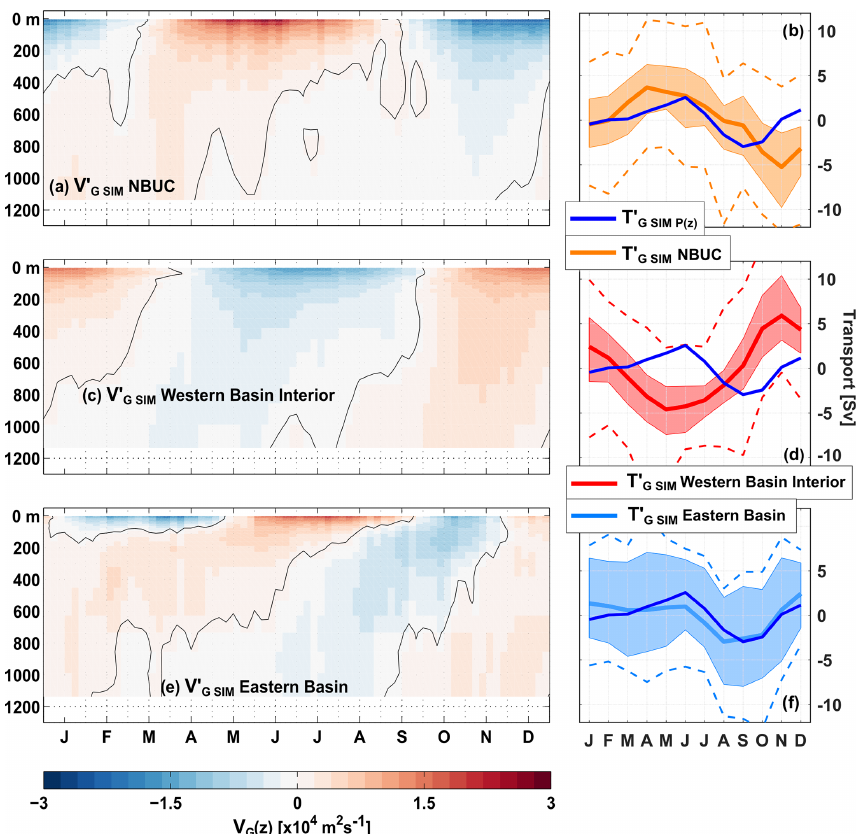
Figure 12. Mean seasonal cycle of the geostrophic transport per unit depth, V (cid:48) (b, d, f) from INALT01. In all panels, V (cid:48) simulated pressure but from pressure differences across different regions along 11 ◦ S: across the whole basin ( T (cid:48) panels b , d , f ); between the Brazilian continental slope and 34.55 ◦ W ( V (cid:48) between 34.55 ◦ W and 10 ◦ W ( V (cid:48) and the Angolan continental slope ( V (cid:48) and dashed curves are the same as in Fig.